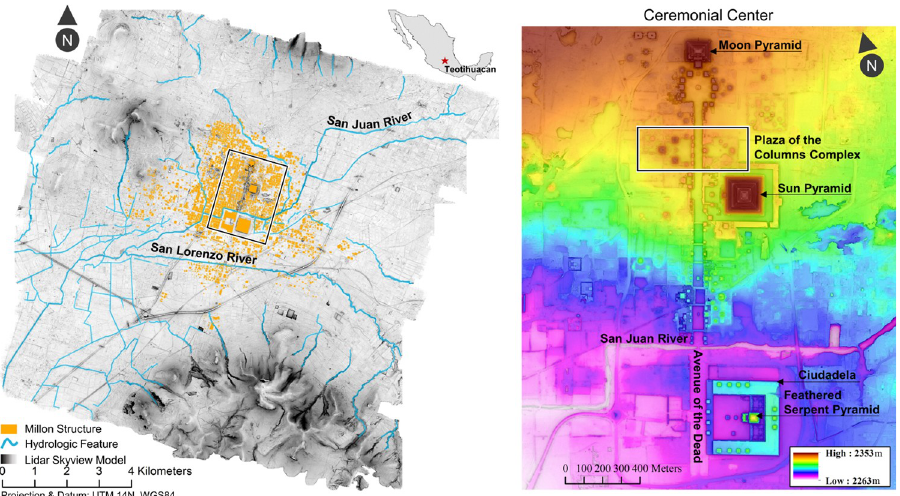
Fig 1. Lidar maps of Teotihuacan Valley. A) skyview factor visualization indicating hypothetical city reconstruction by Millon (29) (yellow) and hydrological systems (blue), and B) color-ramped DEM view of the ceremonial center (rectangle box on left map). Published under a CC BY license, with permission from N. Sugiyama, original copyright Project Plaza of the Columns Complex 2021.